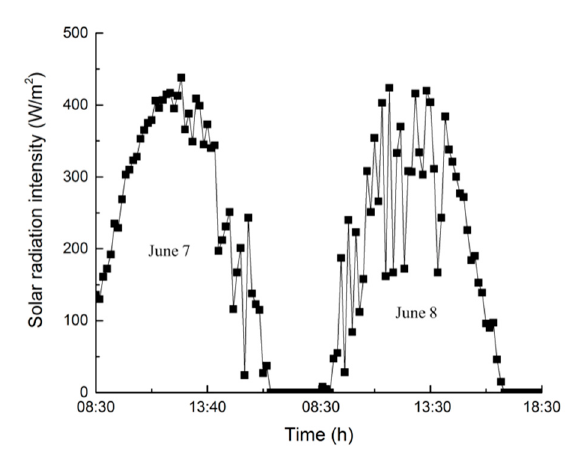
Figure 5. The change of solar radiation intensity.